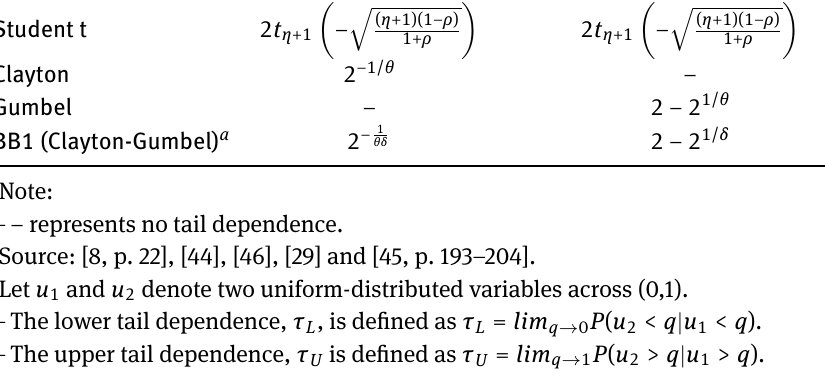
Table 1: Main tail dependence features for each copula Family τ L τ U Gaussian − ( if ρ = 1 then 1) − ( if ρ = 1 then 1)